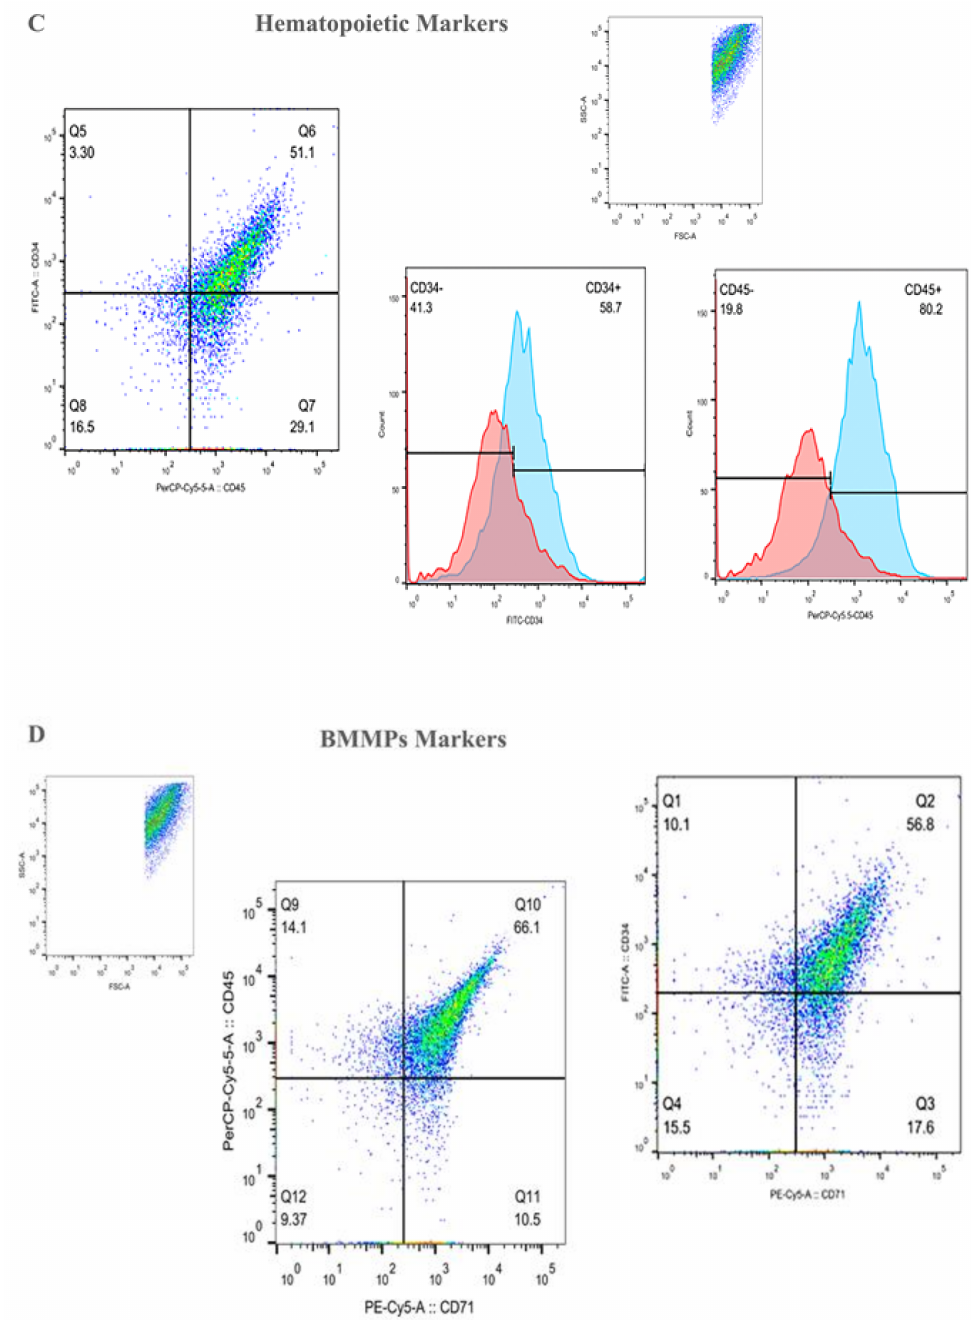
Figure 3. The population of the adherent Bone Marrow Mesenchymal Progenitors (BMMPs) was ac- quired and analyzed using the Forward scatter (FSC) and the Side scatter (SSC) distribution of the cells ( B – D ). Histogram plots show the positivity for the mesenchymal markers CD29, CD71, CD105, CD44, CD90, and CD73 ( A ), with a high positive percentage for double stained population CD29/CD105, CD90/CD44 and CD90/CD73 ( B ). BMMPs were also highly positive for the hematopoietic markers CD34 and CD45 ( C ) alone and in co-expression with the CD71 MSCs marker ( D